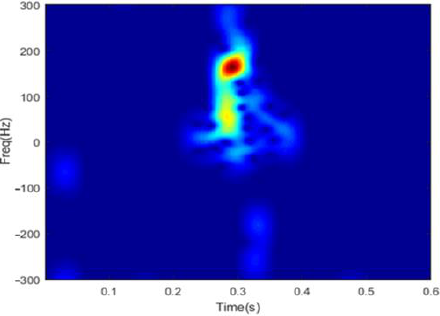
Figure 2. Spectrogram of reconstructed signal using the OMP algorithm.